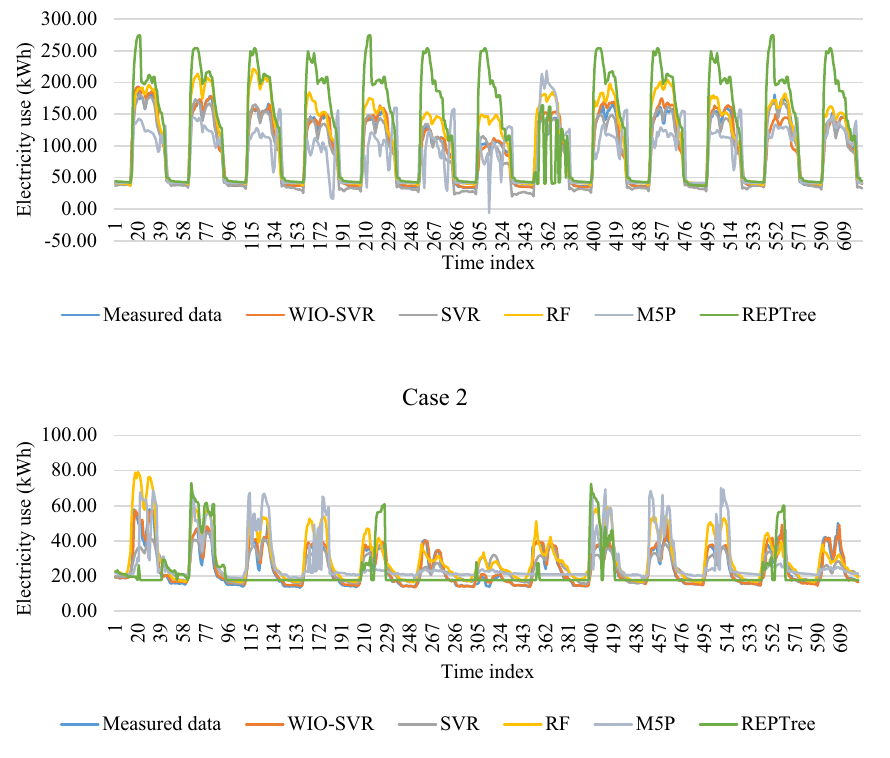
Figure 13. The actual values and predicted values obtained by all models for cases 1 and 2.